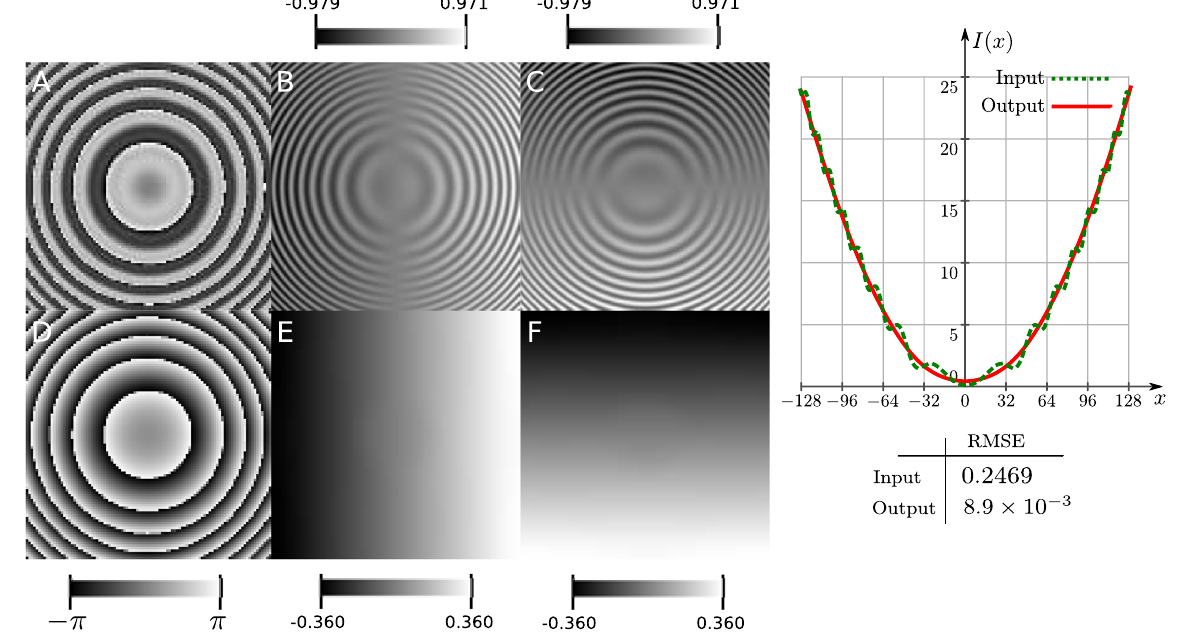
Figure 3. Wrapped phase with miscalibration errors. In ( A ) we see the wrapped phase, ( B and C ) show the x and y frequency fields. In ( D ). We show the recovered phase after frequency reconstruction and integration. The phase is shown wrapped for comparison proposes. In ( E and F ) we show the reconstructed frequencies. The graph at the right shows a plot of the central row of the unwrapped input and the unwrapped output of images ( A and D ) respectively. Color bars show the dynamic range of the